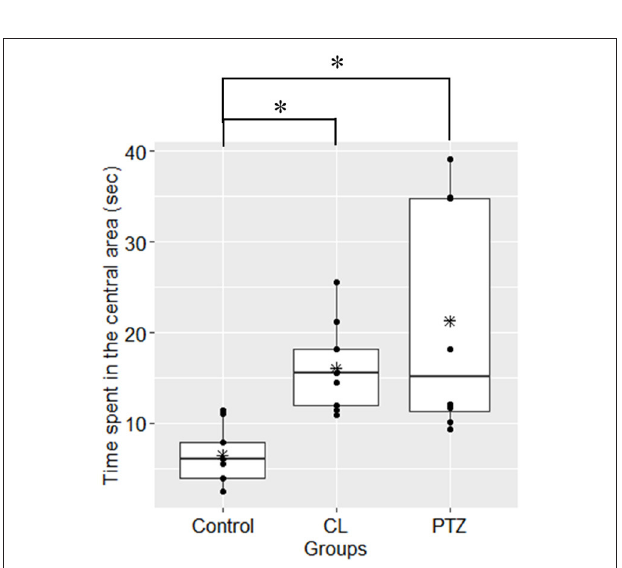
Further multiple comparisons (Tukey’s HSD-corrected) revealed that the PTZ group ( n = 8, 21.26 ± 12.75 s, P = 0.002) and CL group ( n = 9, 16.07 ± 4.84 s, P = 0.04) spent more time in the central area than the control group ( n = 9, 6.47 ± 3.13 s). The proportion of time spent in the central area was also significantly different between groups (ANOVA, P = 0.002; PTZ group 7.09%, CL group 5.36%, control group